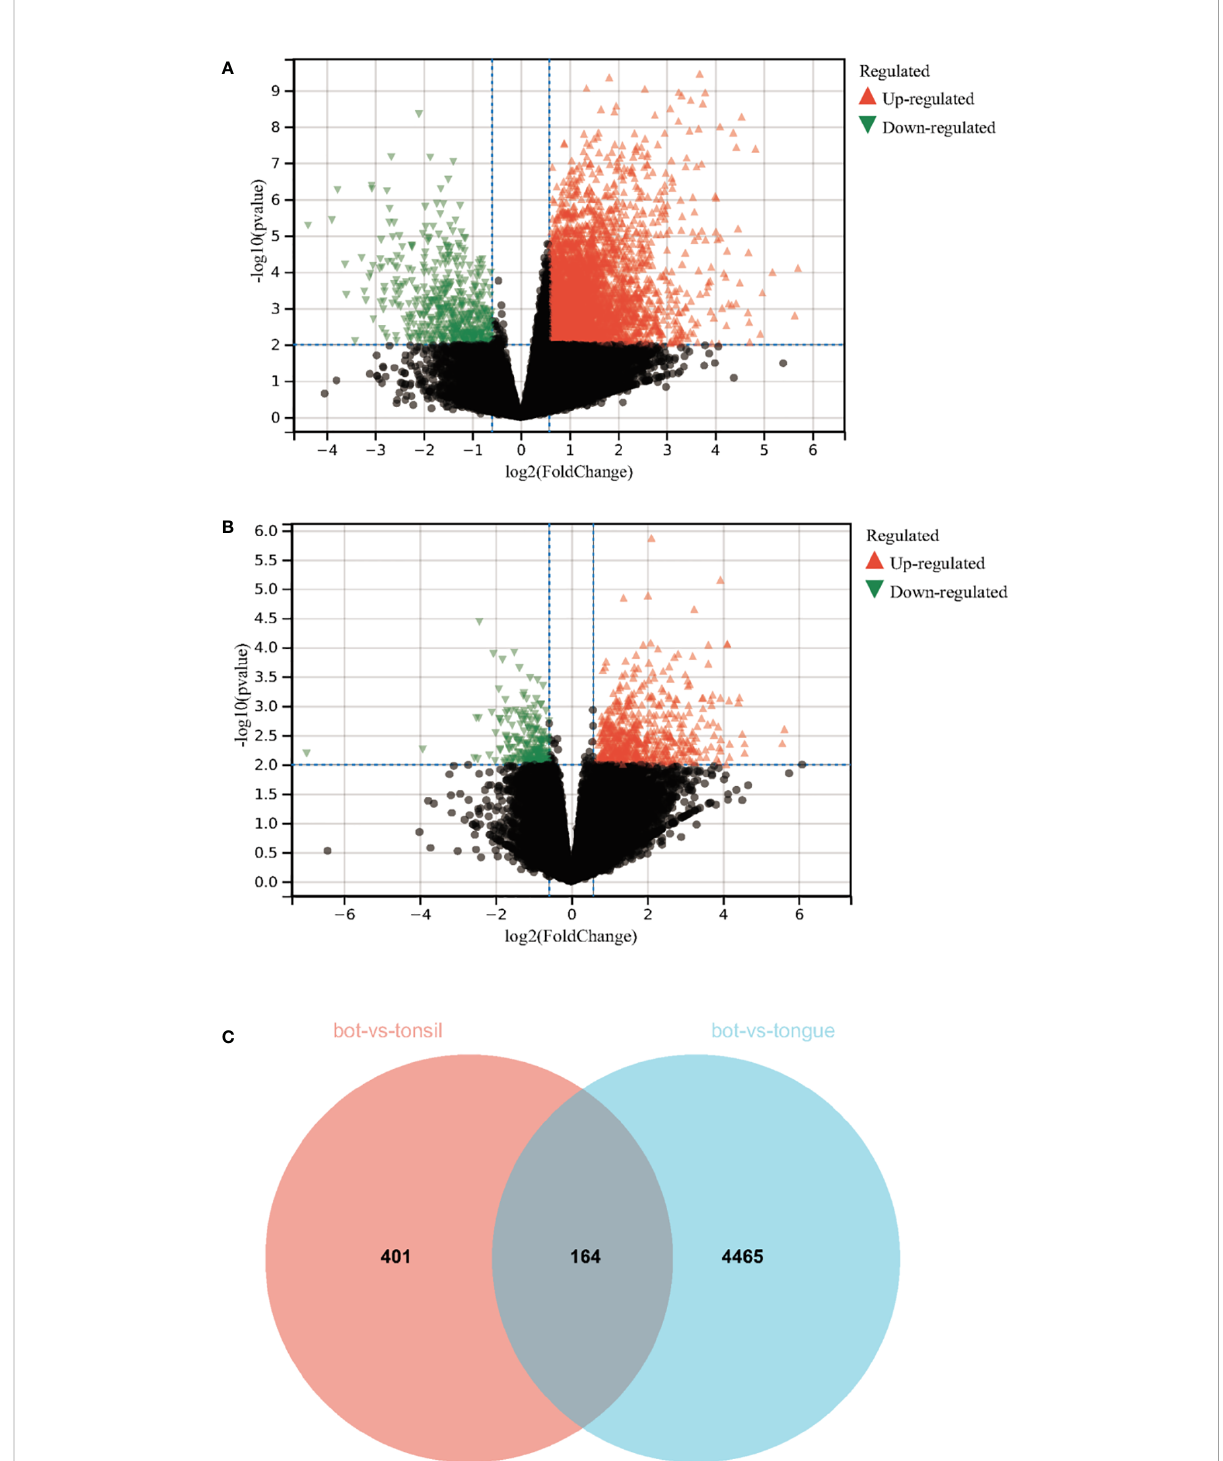
FIGURE 1 Identi fi cation of the speci fi c genes in BOT carcinoma. (A) The volcanic map of the differentially expressed genes between BOT carcinoma and oral tongue carcinoma. (B) The volcanic map of the differentially expressed genes between BOT carcinoma and tonsillar carcinoma. (C) A total of 164 upregulated genes of BOT carcinoma in oral tongue carcinoma and tonsillar carcinoma were analyzed by Veen diagram. Genes with Log2|fold change (FC)| > 1.5 and FDR < 0.01 were found to be differentially expressed and had signi fi cant